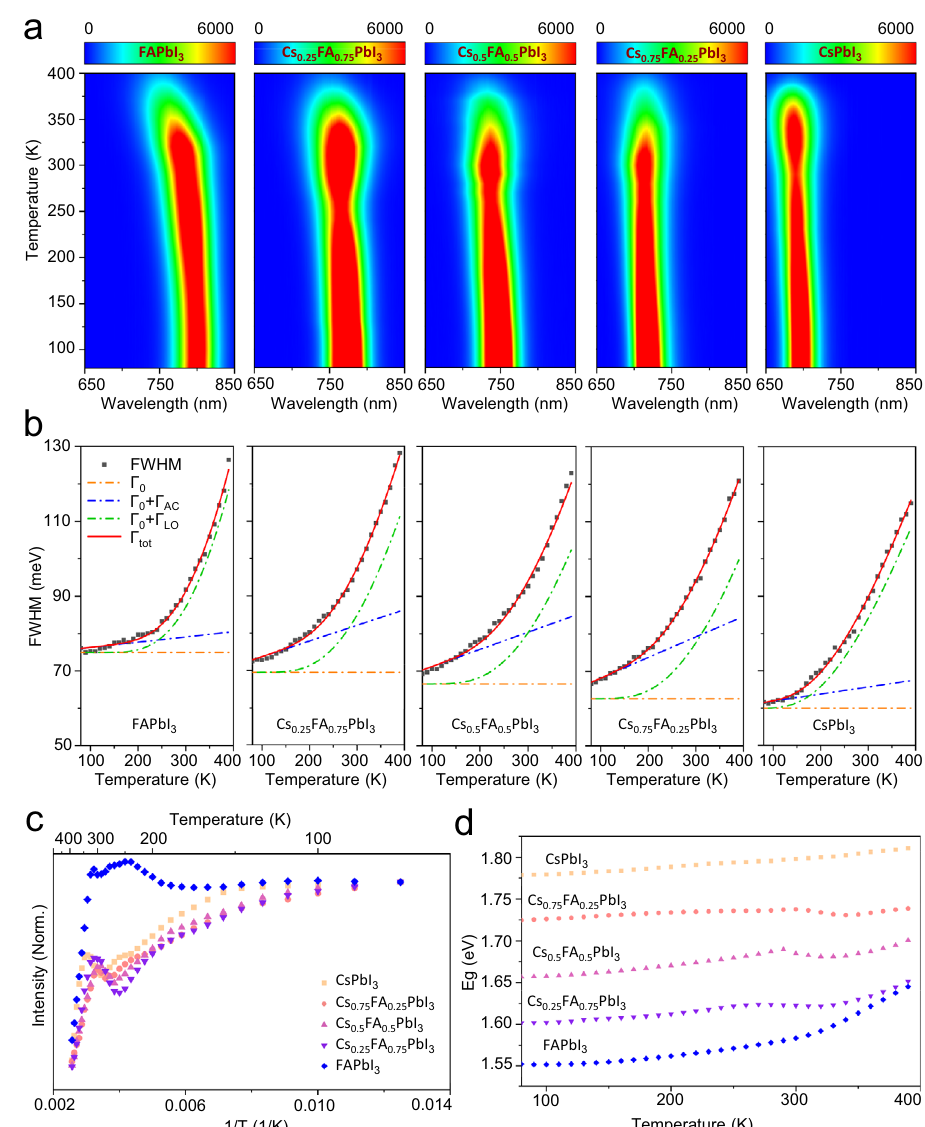
interaction Γ ( T ) = Γ 0 + Γ AC (blue dash-dot line), and longitudinal optical phonon interaction Γ ( T ) = Γ 0 + Γ LO (green dash-dot line). c , d Thetemperaturedependence of normalized PL intensities and bandgaps for different Cs x FA 1-x PbI 3 PQDs. The PL intensity is normalizedbyits value at80K.The bandgap values are extracted using the Gauss fi t. Source data are provided as a Source Data fi